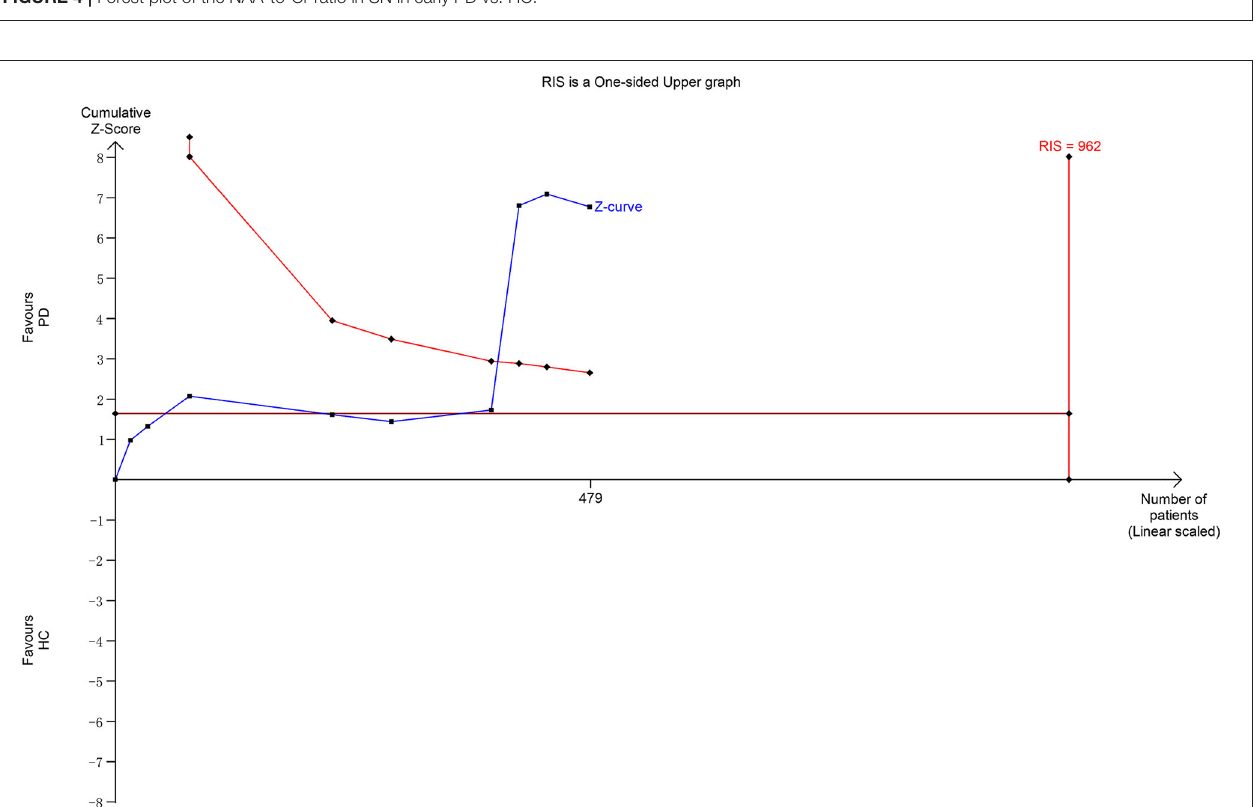
FIGURE 5 | Trial sequential analysis of the NAA-to-Cr ratio in SN.